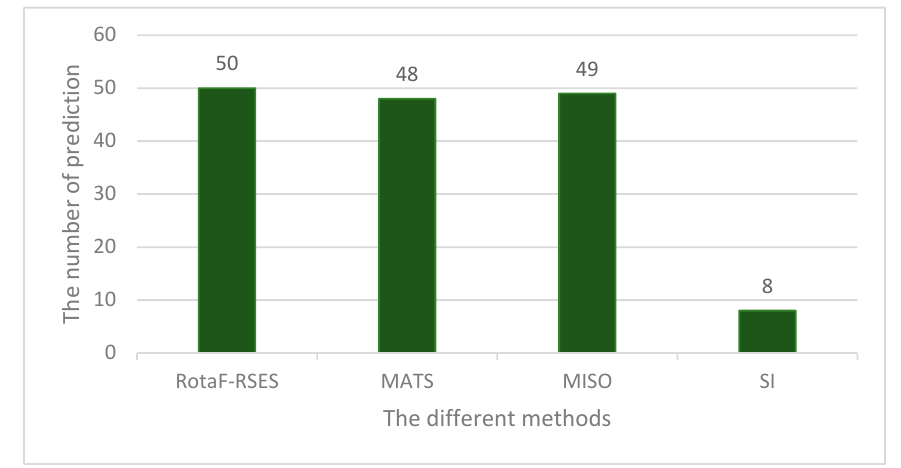
Figure 6. The prediction results of the RotaF-RSES, MATS, MISO, and SI methods on test data.